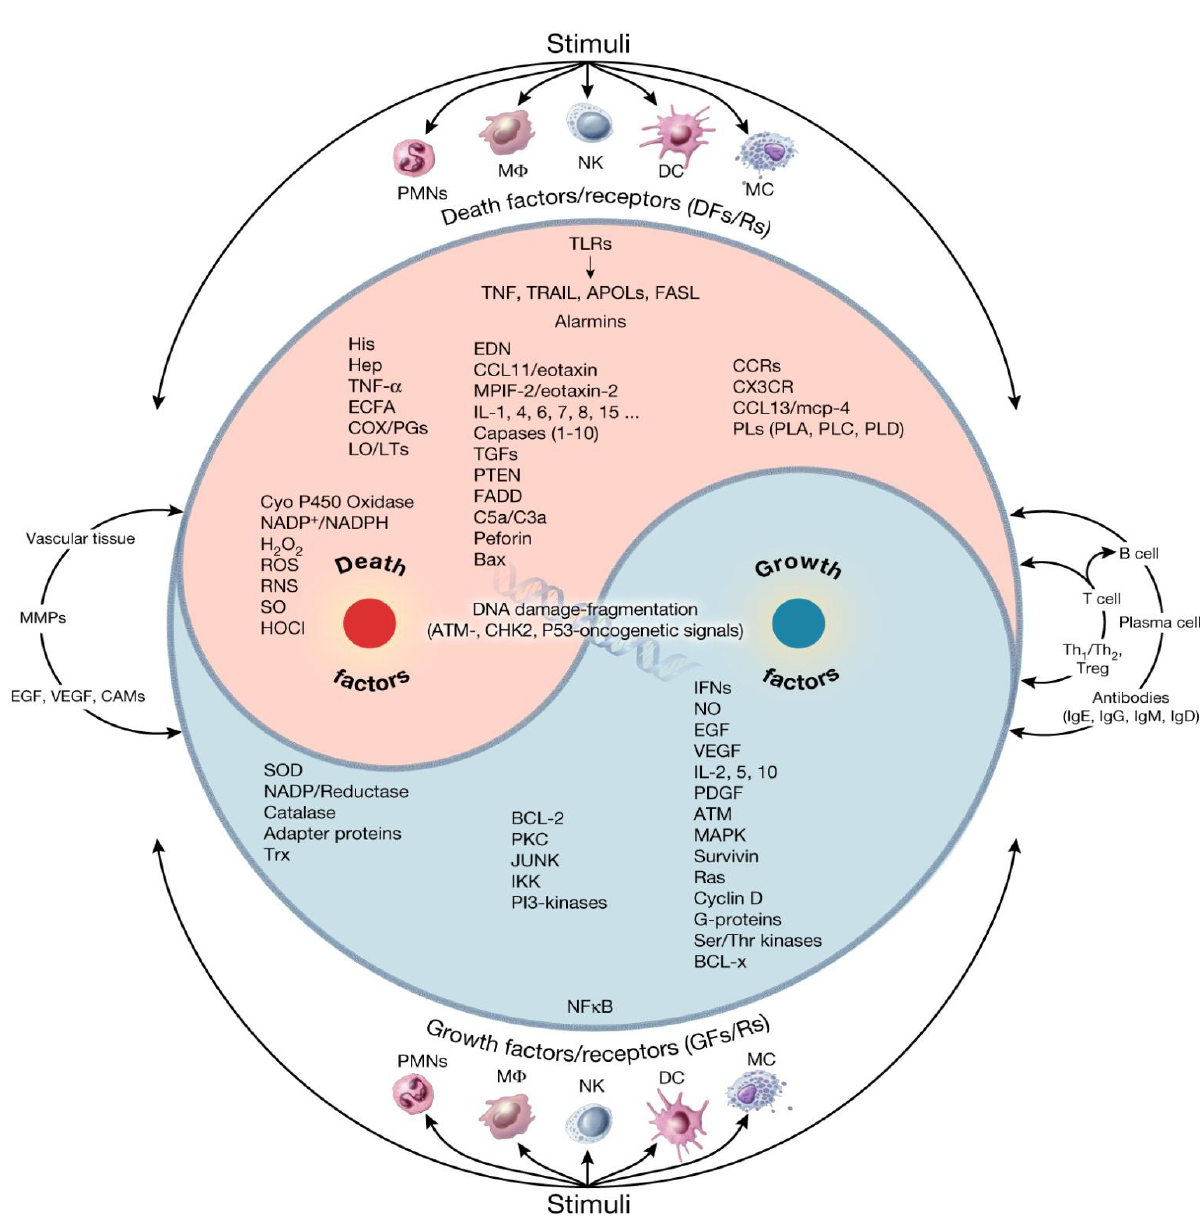
Figure 2. Schematic representation of Yin (Death factors) and Yang (Growth factors) processes in acute inflammation. Reproduced from Khatami [38] with permission from Informa Healthcare, all rights